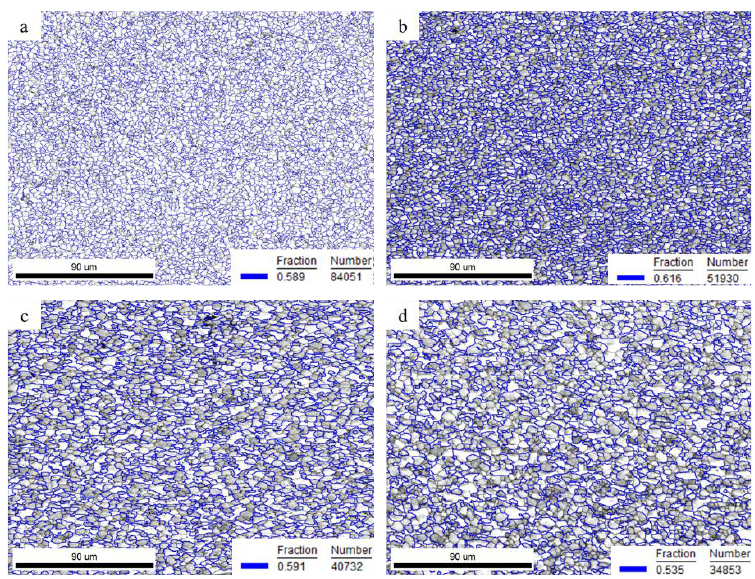
Figure 9. The spread of α/β phase boundaries at different positions deformed at 760 °C: ( a ) the grip position, ( b ) the gauge section near the grip, ( c ) the middle of the gauge section, and ( d ) section near the tip of the fracture.